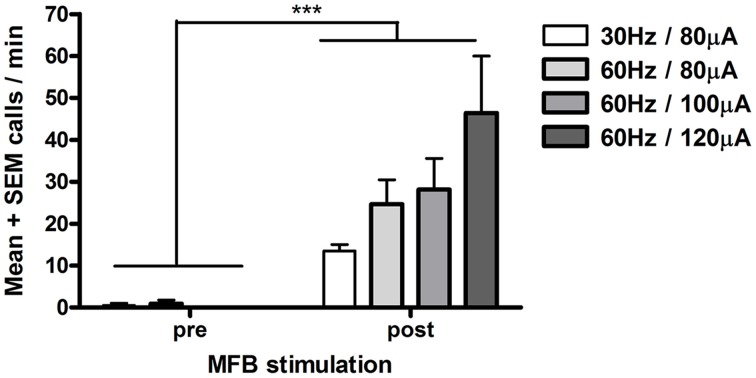
Electrical stimulation of the medial forebrain bundle (MFB) and 50-kHz call rate (Experiment 1). Each rat (n = 3) was tested under each stimulation condition. Calls after MFB stimulation (post, 0–55 s following stimulation onset) were significantly greater than calls before MFB stimulation (pre, 0–55 s before stimulation). Each stimulation train was spaced 5–6 min apart. ***p < 0.002 pre vs. post (Sign test, n = 12 i.e., 4 stimulation parameters × 3 rats).